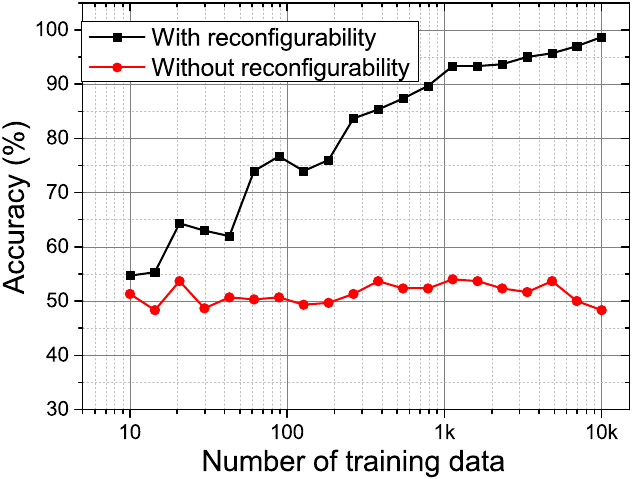
Figure 10. The prediction accuracy by support vector machine (SVM) for the proposed PUF with and without